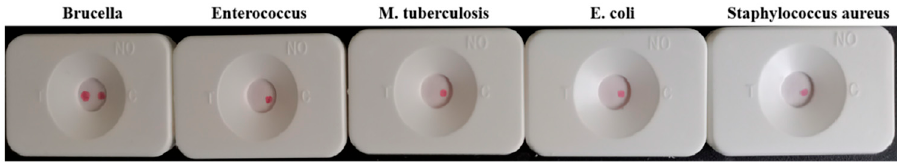
Figure 12. Specific results for RVFT.